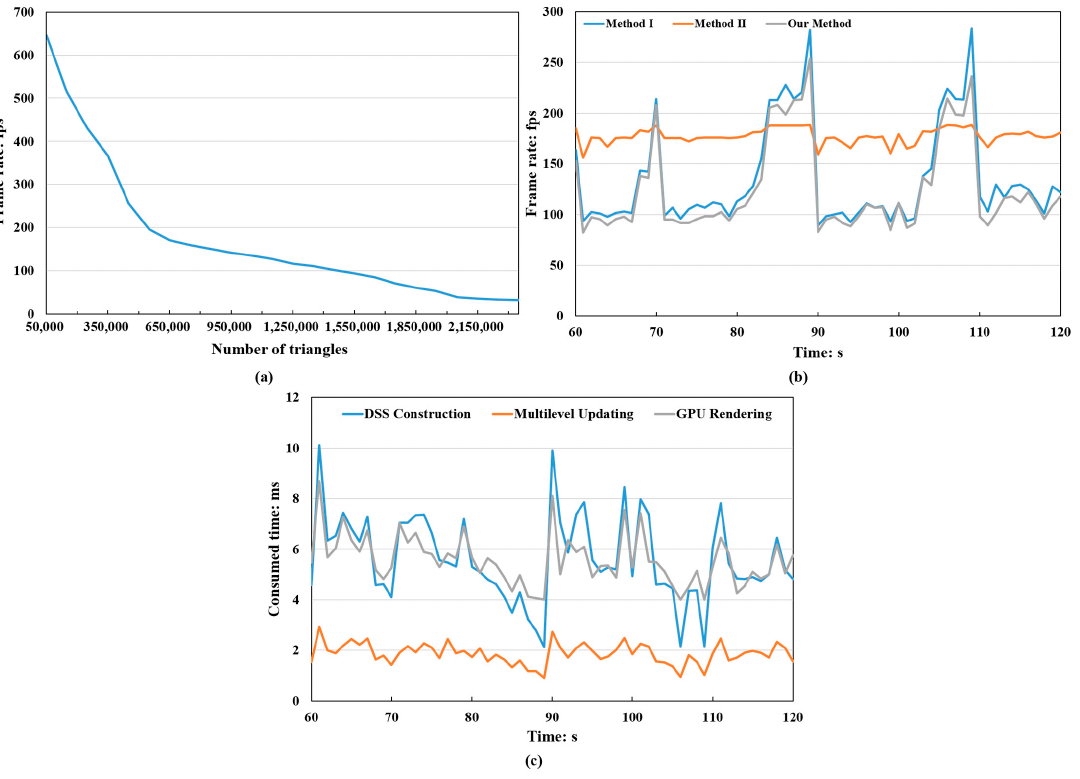
Figure 20. Efficiency test using a 4097 × 4097 height map with a 1280 × 960 viewport: ( a ) Frame rates and data amount. ( b ) Performance comparison. ( c ) Consumed time of different stages in our method.